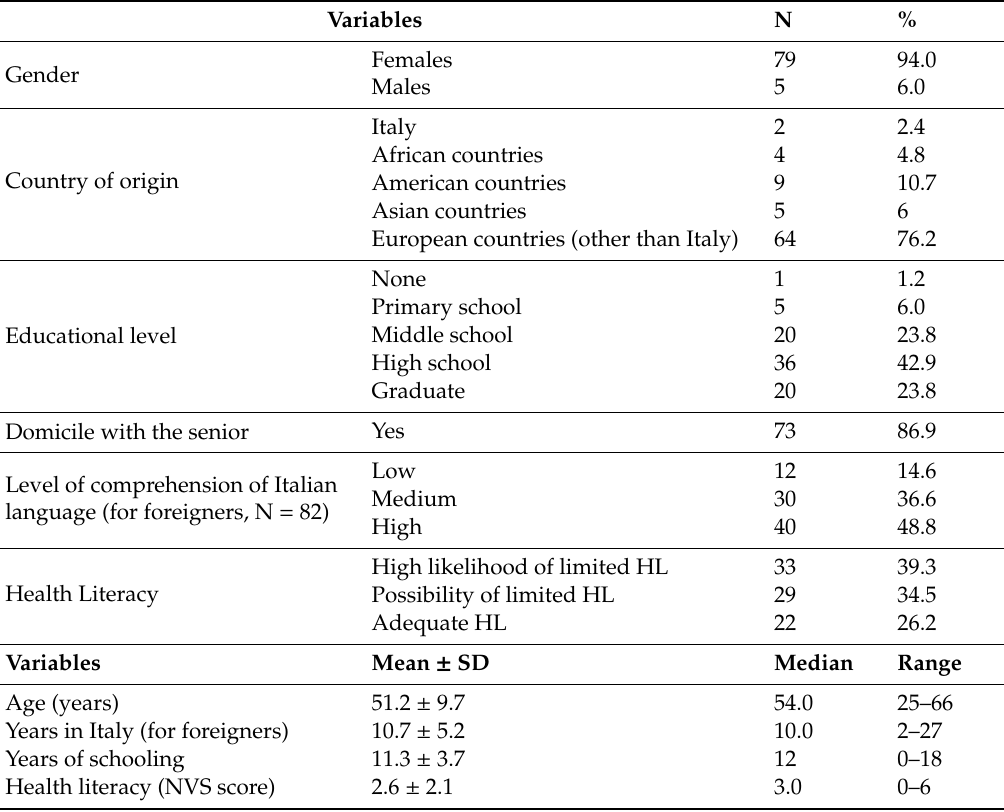
Table 1. The sample interviewed at home: descriptive analysis (N = 84). Variables